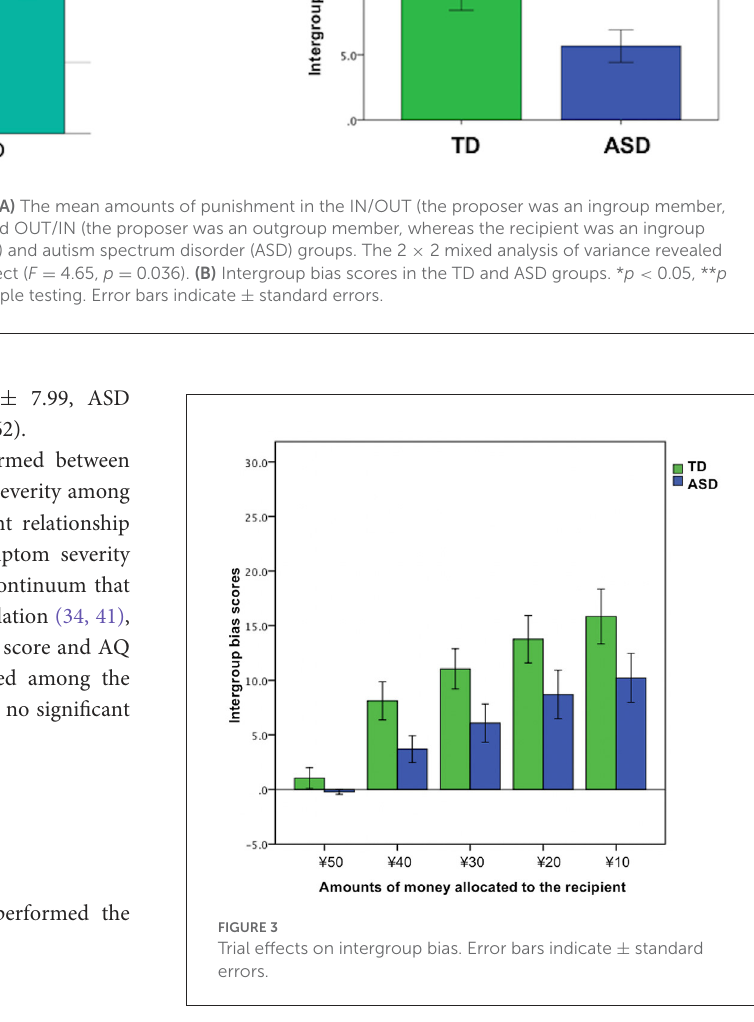
FIGURE3 Trial effects on intergroup bias. Error bars indicate ± standard